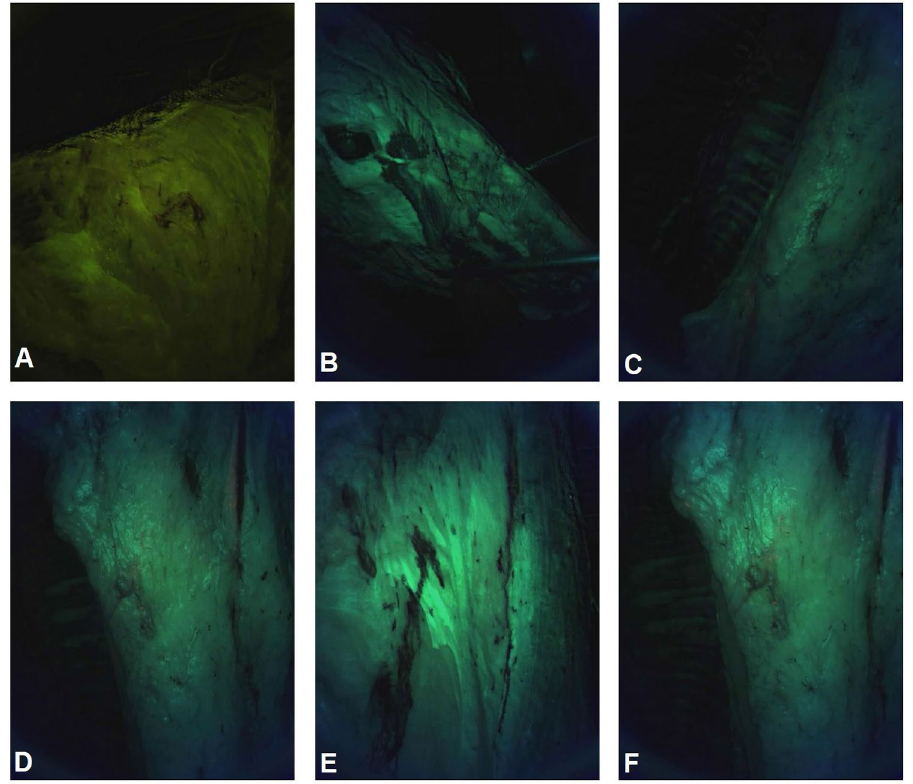
Figure 2. Six CSI-D fluorescence images of clean meat surfaces ( A – F